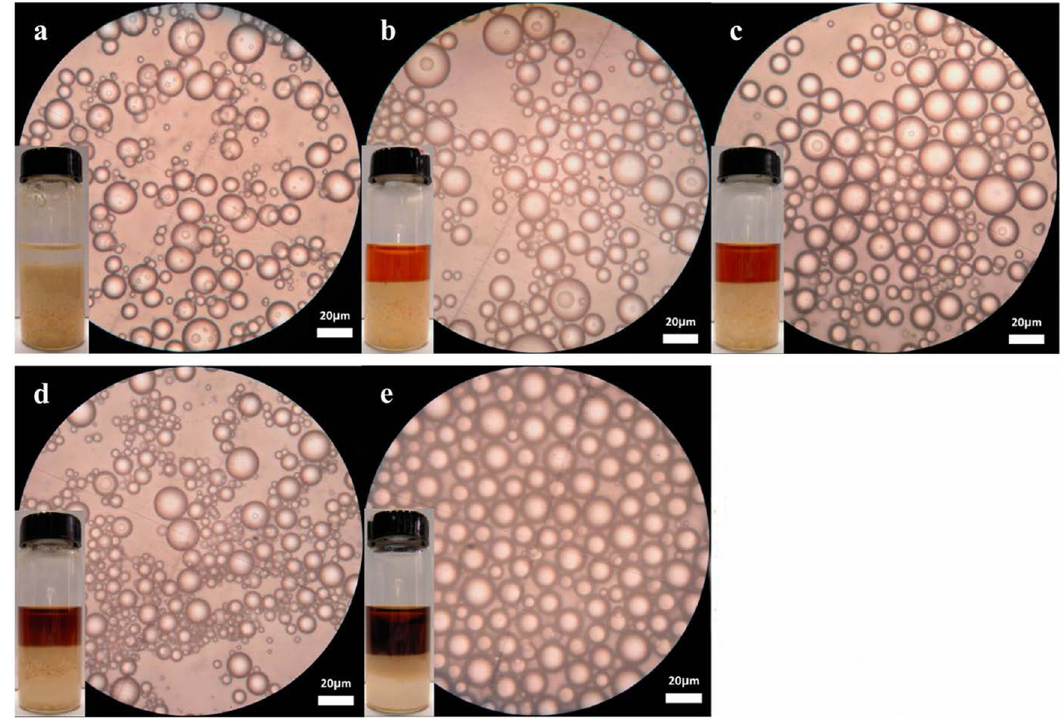
Figure 4: Pickering emulsions stabilized by GO at di ff erent pH values: ( a ) pH = 1, ( b ) pH = 3, ( c ) pH = 6, ( d ) pH = 9, and ( e ) pH = 11 [ 46 ]